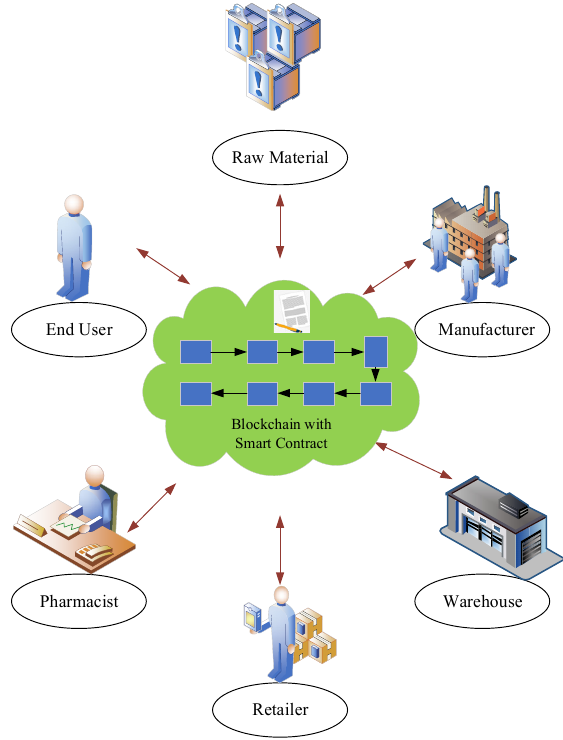
Figure 5. System architecture of blockchain with smart contract.